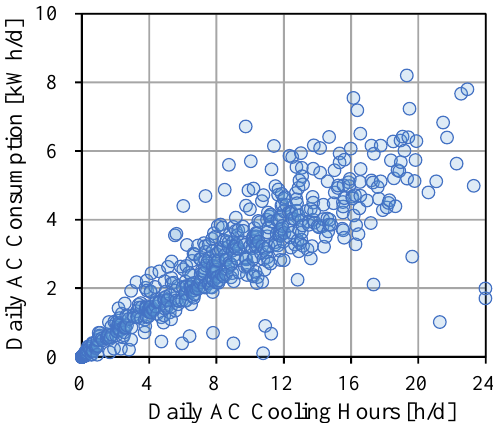
Figure 4. Scatter plot of average cooling hours and AC electricity consumption for each household per day.